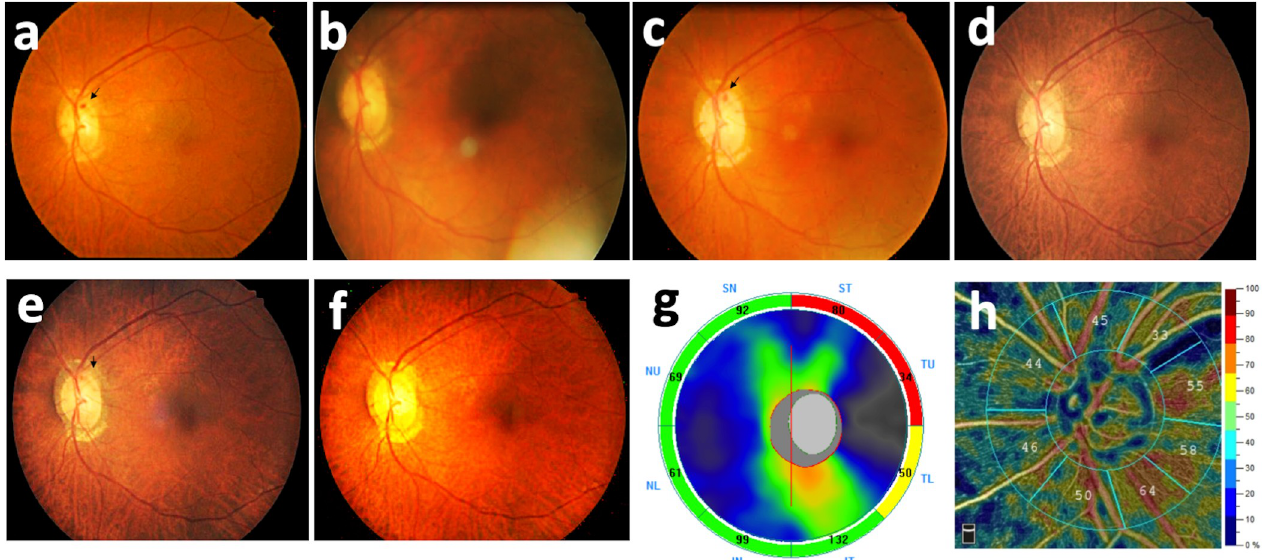
Fig 4. A 68-year-old woman with recurrent DH after a 7-year follow-up. Two episodes of recurrent DH were noted in the same area. (a) Initial DH (arrow). (b) Resolution of initial DH. (c) First recurrent DH (arrow) developed 2 years after the initial DH. (d) Resolution of the first recurrent DH. (e) Second recurrence of DH (arrow), 2 years after the first recurrence. (f) Resolution of the second recurrent DH. (g) & (h) In final visit, optical coherence tomography and angiography revealed RNFL thinning and decreased VD in the superotemporal area corresponding to findings on a color fundus photo.